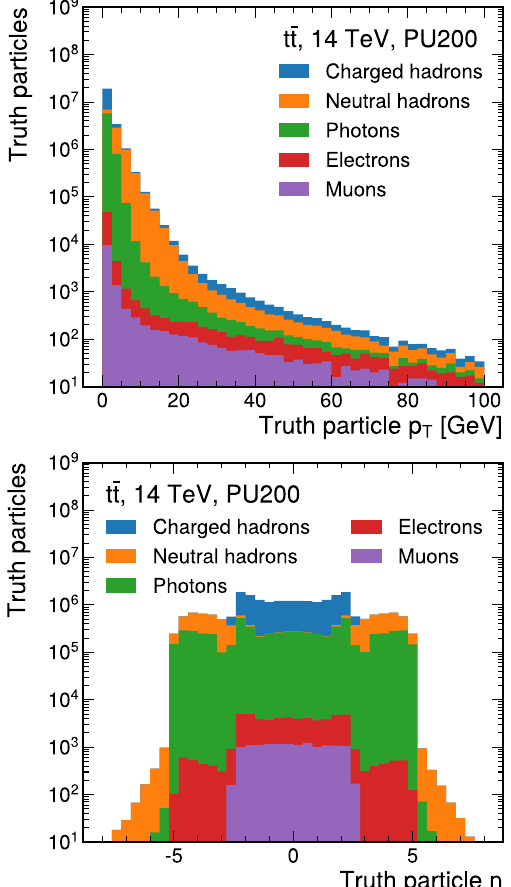
Fig. 2 The p T (upper) and η (lower) distributions of the generator particles in the simulated tt dataset with PU, split by particle